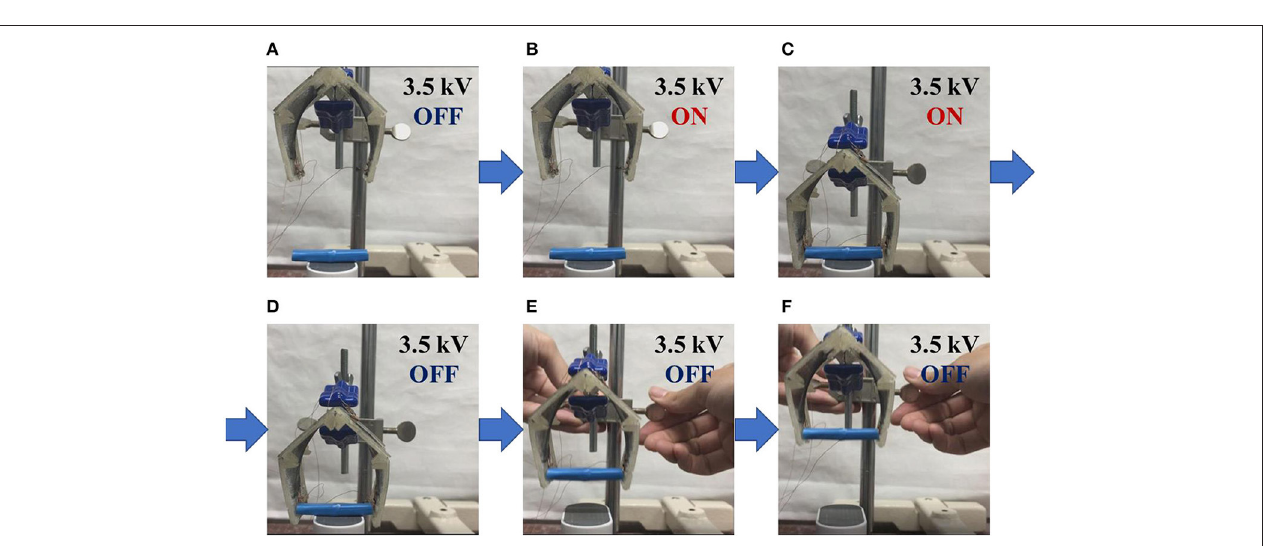
FIGURE 17 | The structure of the gripper. The center joint was designed to be 90 ◦ , and the left and right joints were designed to be 120 ◦ . (A) Frames are pasted on an elastomer given pre-strain of 300%. (B) When the elastomer outside the frame is removed, the gripper structure is formed. (C) Appearance of the gripper.